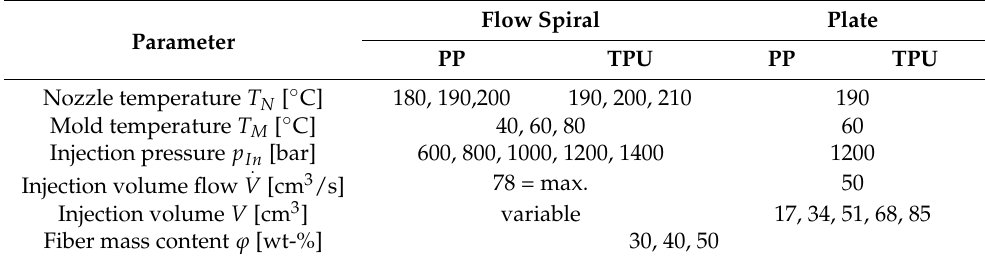
Table 1. Injection molding parameters used.